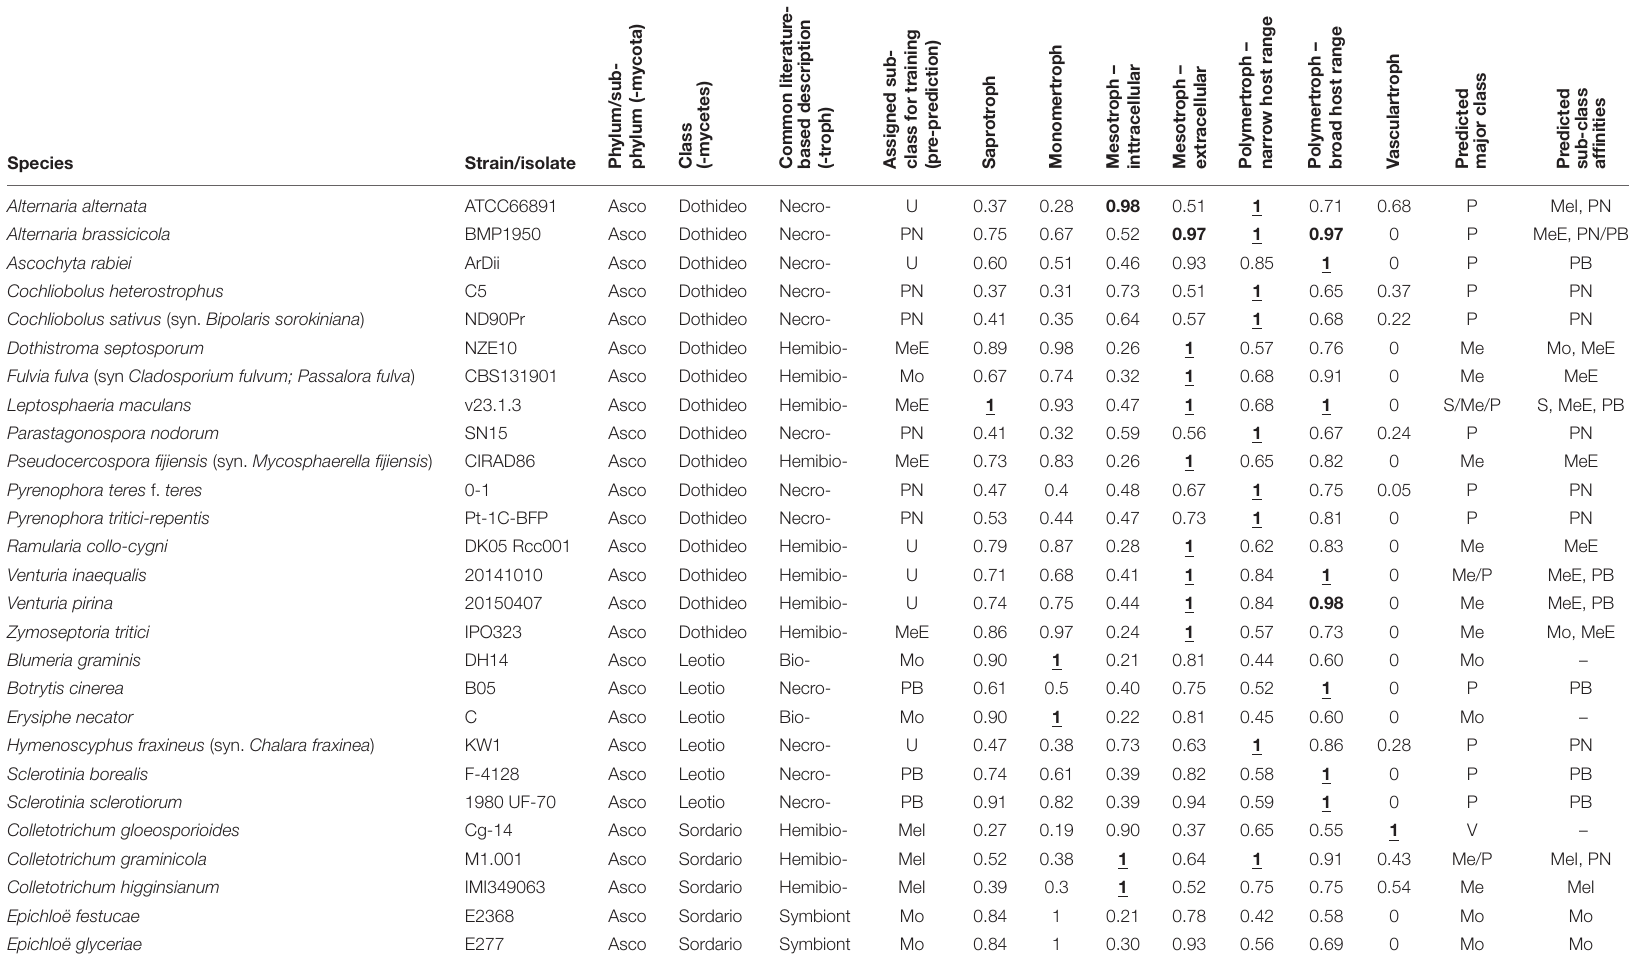
TABLE 2 | Summary of predicted CATAStrophy classifications for selected fungal and oomycete species (full version in Supplementary Data Sheet S1